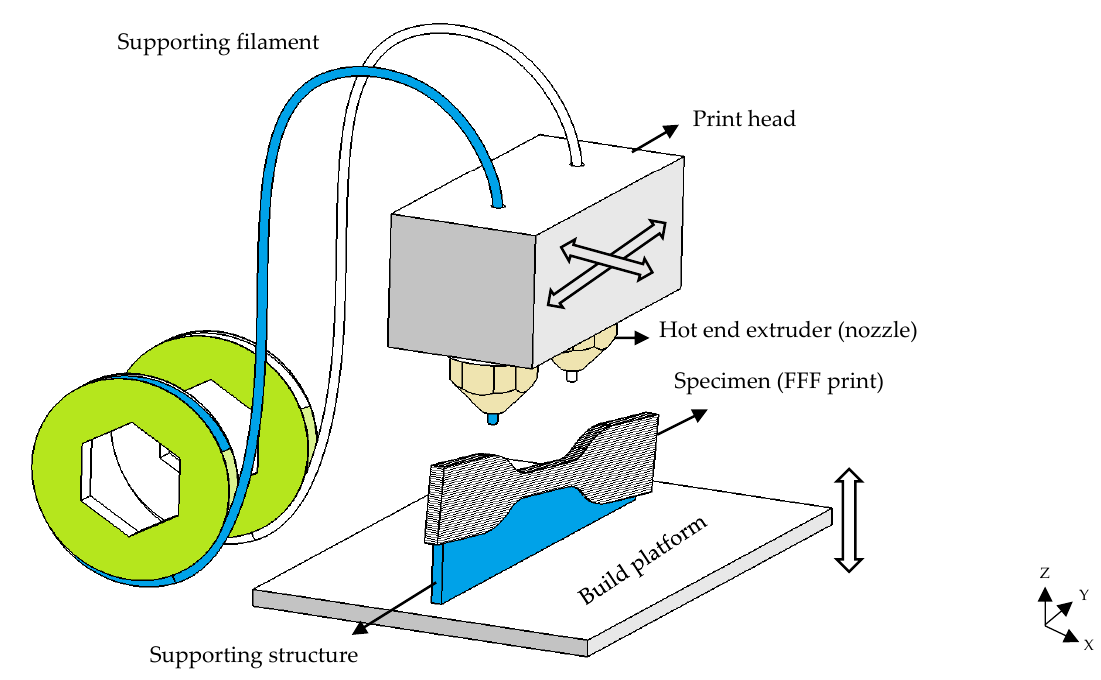
Figure 1. Schematic illustration of the FFF process.